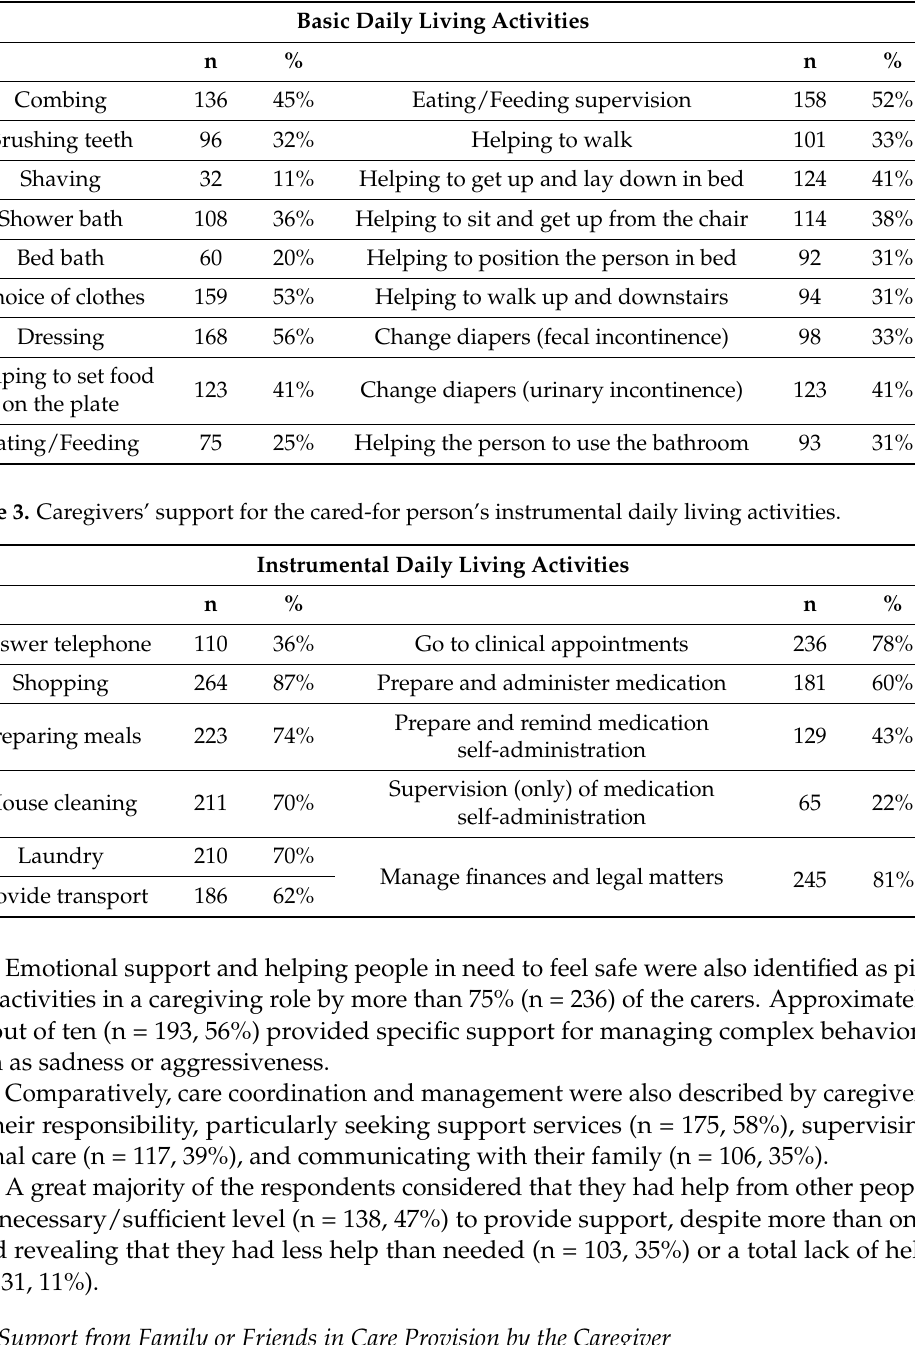
Table 2. Caregivers’ support for the cared-for person’s basic daily living activities.